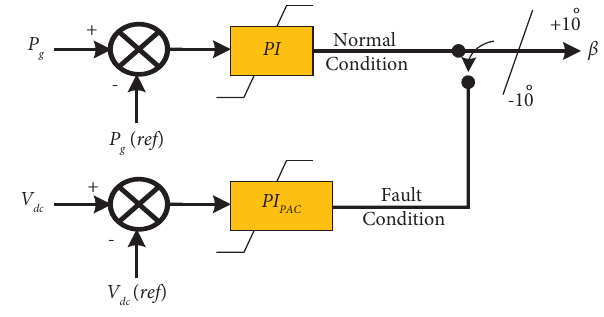
Figure 17: Operation of the PAC system.